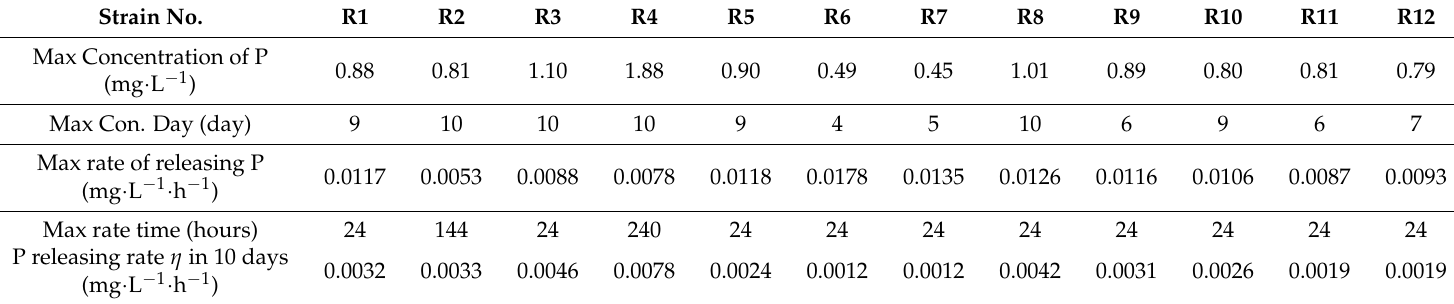
Table 2. Maximum concentration and rate of P release for 10-day incubation in liquid medium with organic P (lecithin). Strain No.